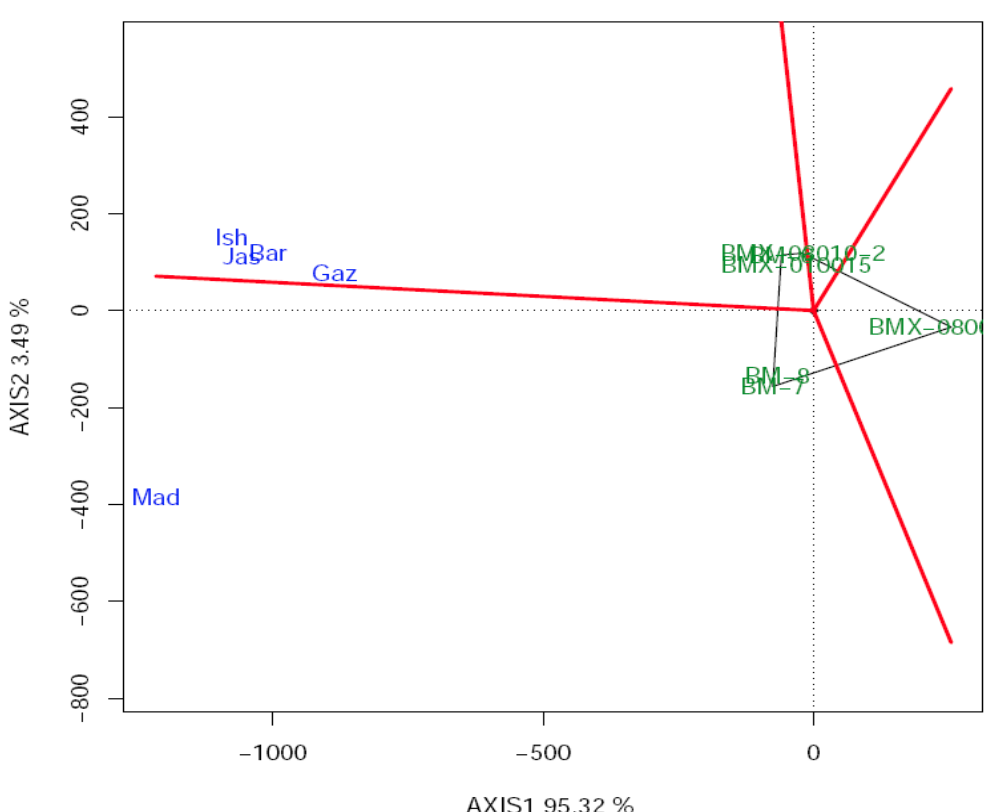
Figure 5. GGE Biplot displaying the position of genotypes and environments. The genotypes BM-6, BM-7, and BM-8 stand for BARI Mung-6, BARI Mung-7, and BARI Mung-8, respectively, and the environments Ish, Gaz, Jas, Bar, and Mad stands for Ishurdi, Gazipur, Jashore, Barishal, and Madaripur, respectively.